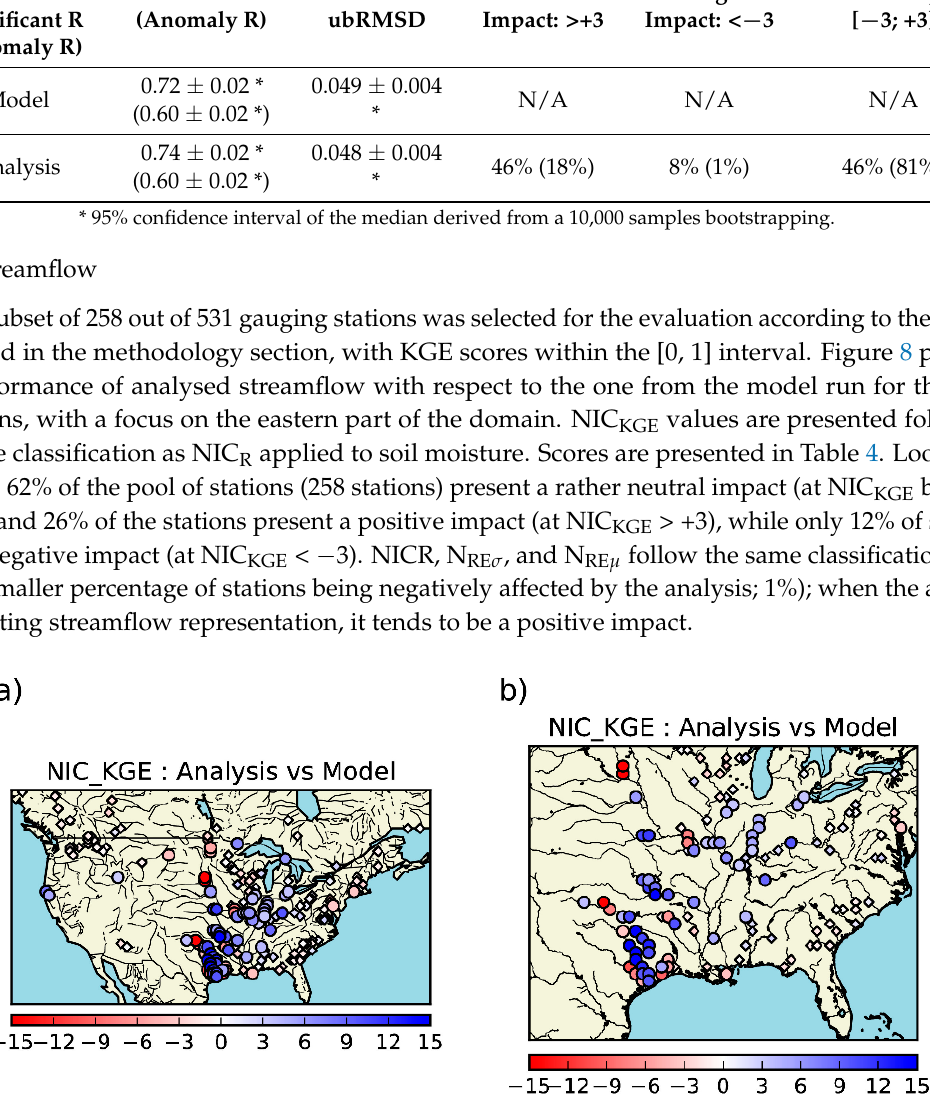
Figure 8. Normalized information contribution scores based on Kling–Gupta efficiency (KGE) scores (NIC KGE ) ( a ) analysis with respect to the model, ( b ) zoom over the eastern part of the domain. Small diamonds represent stations for which NIC KGE are between [ − 3; +3]. NIC KGE greater than 3 (blue large circles) suggest an improvement from the analysis over the model, values smaller than − 3 (red large circles) suggest a degradation. For sake of clarity, a factor of 100 has been applied to NIC.